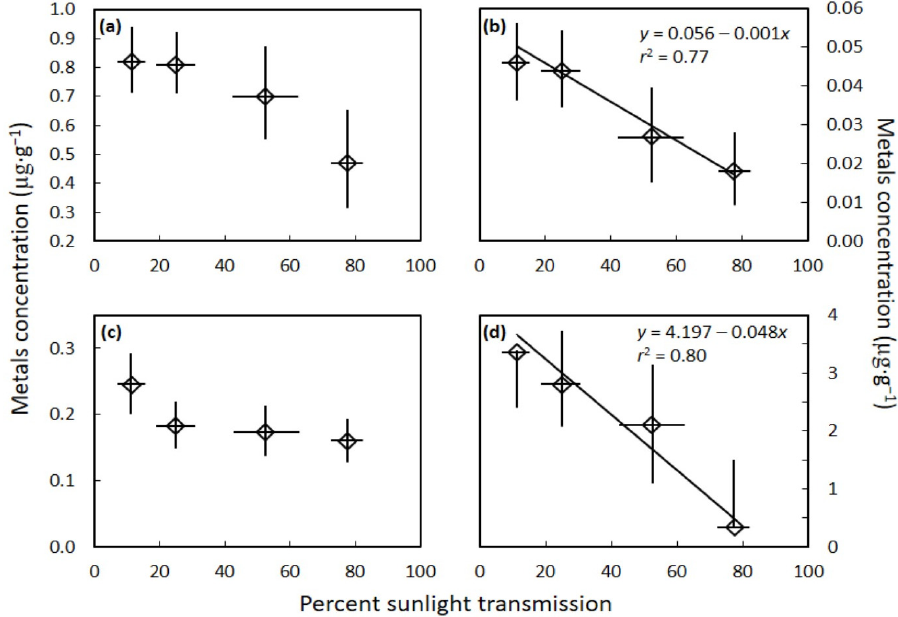
Figure 2. The influence of habitat sunlight transmission on Cycas micronesica seed gametophyte metal concentration. ( a ) aluminum; ( b ) cobalt; ( c ) nickel; and ( d ) selenium. Mean ± standard deviation.